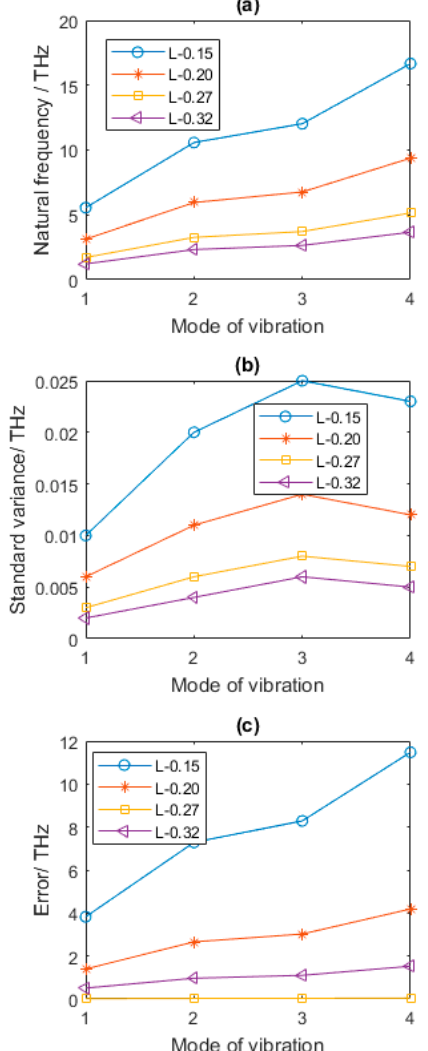
Figure 6. Results of defected graphene sheets with different L ( a – c for mean, standard variance and Error of natural frequency, respectively).